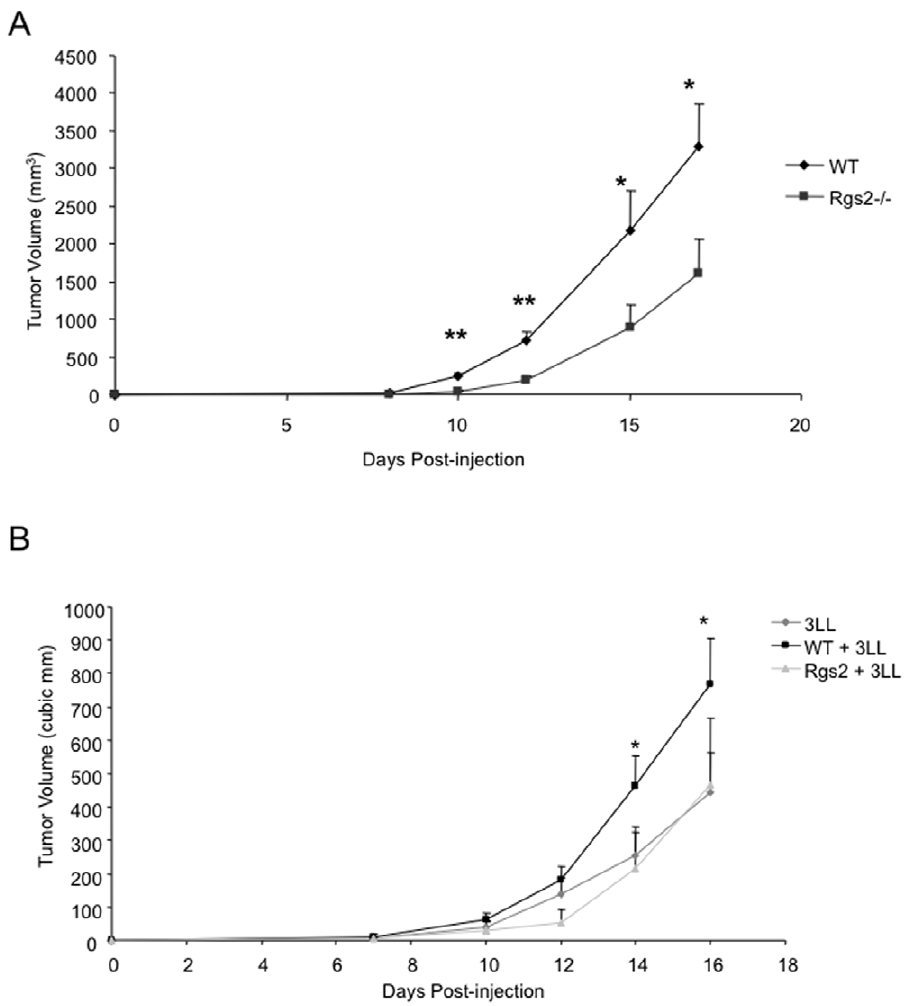
Figure 2. Deletion of Rgs2 in MDSCs retards tumor growth. (A) Rgs2 2 / 2 and C57BL/6 wild type mice were injected with 5 6 10 5 3LL tumor cells subcutaneously in the hindlimb, and tumor size was measured by caliper over time (n=12 mice per group). This experiment was repeated 3 times. (B) Wild type mice were injected subcutaneously in the hindlimb with 1 6 10 5 3LL cells alone, or 3LL cells combined with 1 6 10 4 wild type or Rgs2 2 / 2 MDSCs sorted by flow cytometry ( . 95% purity; data not shown) from spleens of tumor-bearing mice. Tumor growth was measured by caliper over time. n=8 mice per group. This experiment was performed twice. * p , 0.05.